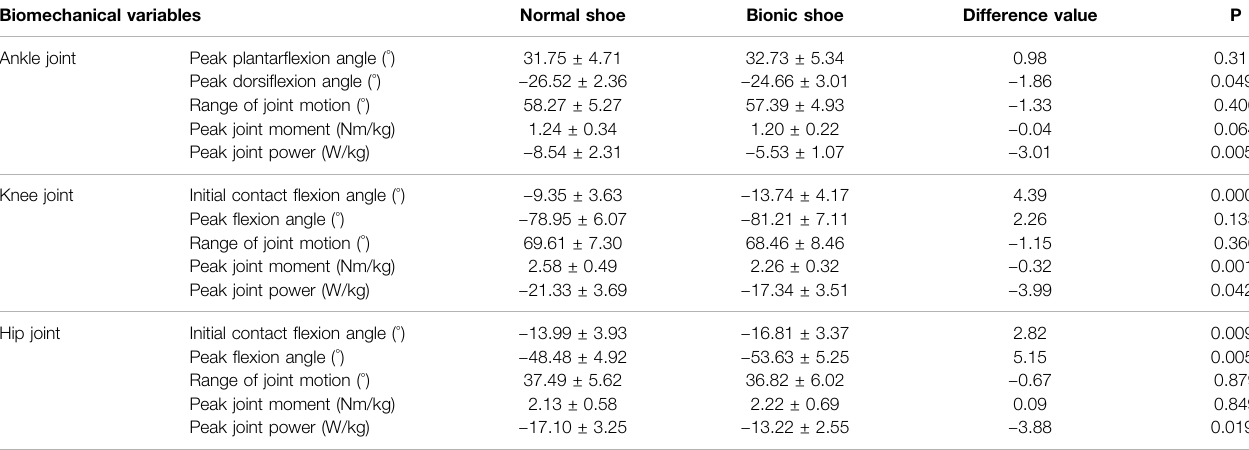
TABLE 1 | Comparison of sagittal plane joint angles, joint moment, joint power (means ± standard) between NS and BS during single-leg landing phase. Biomechanical variables Normal shoe Bionic shoe